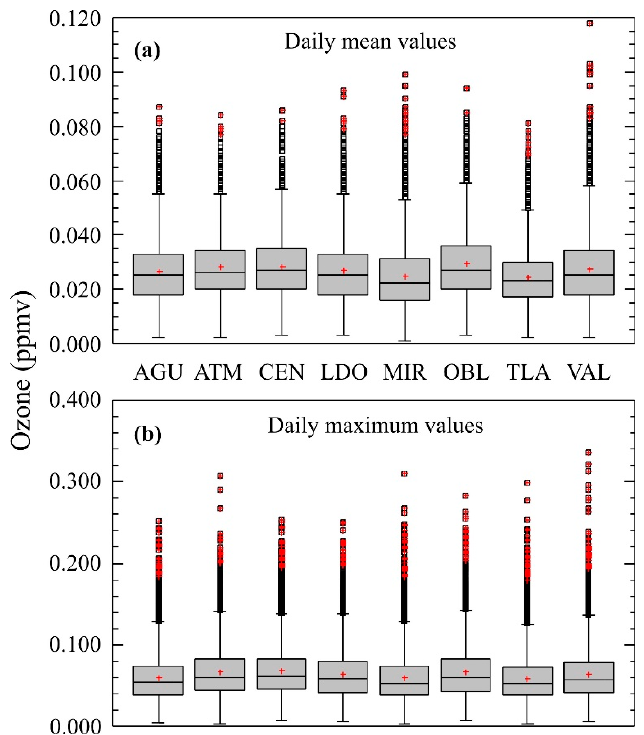
Figure 3. The statistical distribution of the daily ozone concentrations in the 8-stations in the monitoring network of the Guadalajara Metropolitan Area: ( a ) mean ozone, ( b ) maximum ozone. The box and whisker plot denote the lower quartile, median and upper quartile (box), the percentile 5 and 95 (whisker), mean (red asterisk), and outliers (black-red squares). Abbreviations: Las Águilas, AGU; Atemajac, ATM; Centro, CEN; Loma Dorada, LDO; Las Pintas, LP; Miravalle, MIR; Tlaquepaque, TLA; Oblatos, OBL; Santa Fé, SF; Vallarta, VAL.